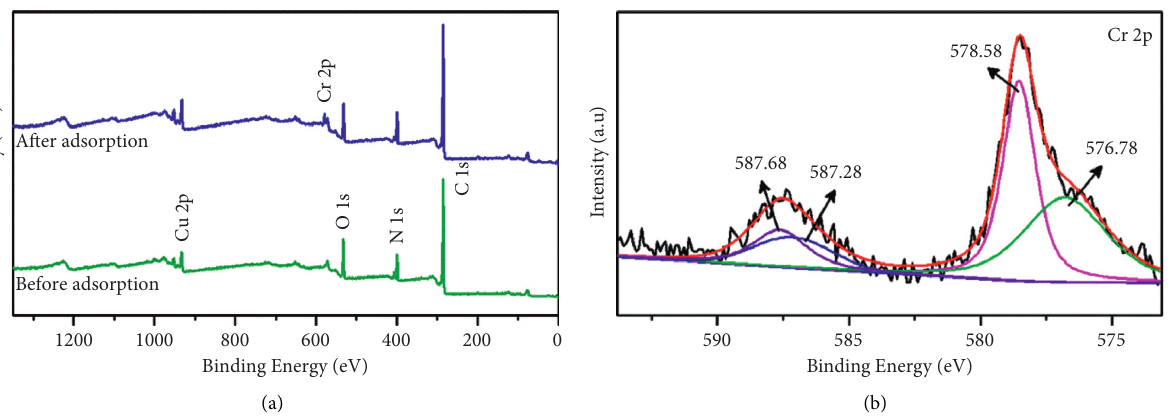
Figure 6: (a) Full-scan XPS spectra of Cu (I)-MOF before and after Cr (VI) adsorption. (b) High-resolution XPS spectra of Cr 2p after adsorption.